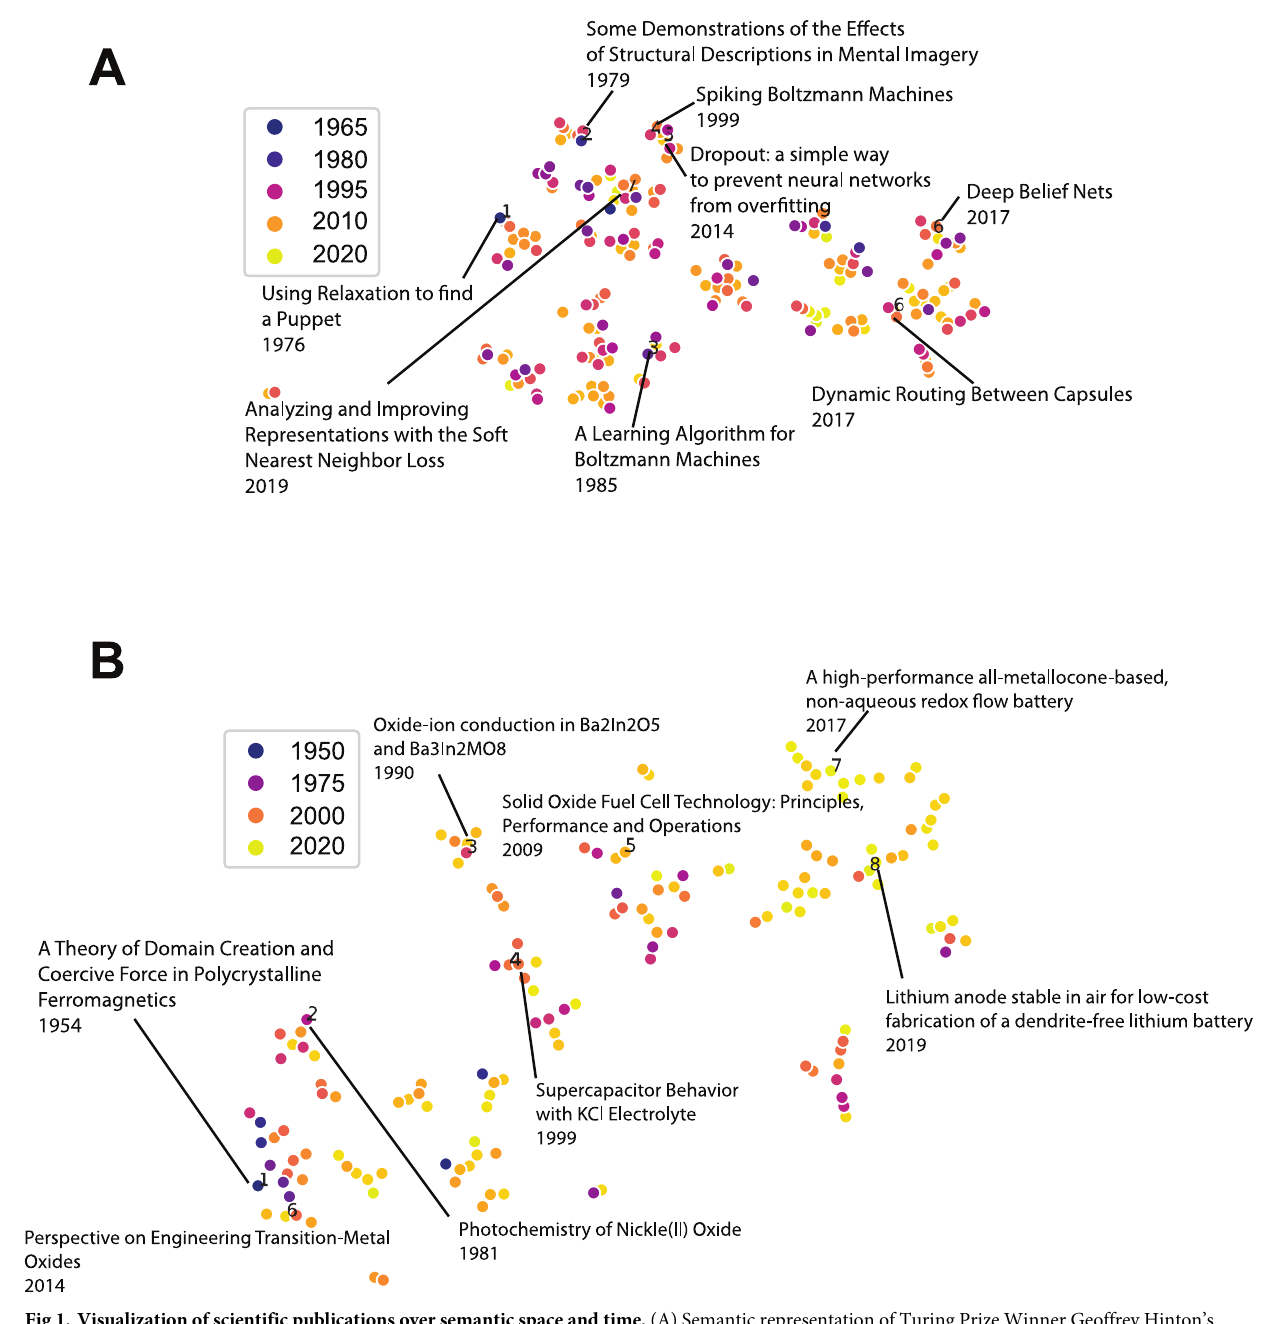
Fig 1. Visualization of scientific publications over semantic space and time. (A) Semantic representation of Turing Prize Winner Geoffrey Hinton’s published papers throughout his career, with annotations on sampled papers. Each dot represents a paper using BERT-based embedding of its abstract that is projected into 2 dimensions via tSNE dimension reduction [38]. Color gradient indicates year of publication, with more recent papers in warmer colors. Distance between abstract embeddings signifies inverse semantic similarity. (B) Similar information for Nobel Prize Laureate John B. Goodenough. Note that the legend shows the gradation of colours, the latest papers from our dataset were from